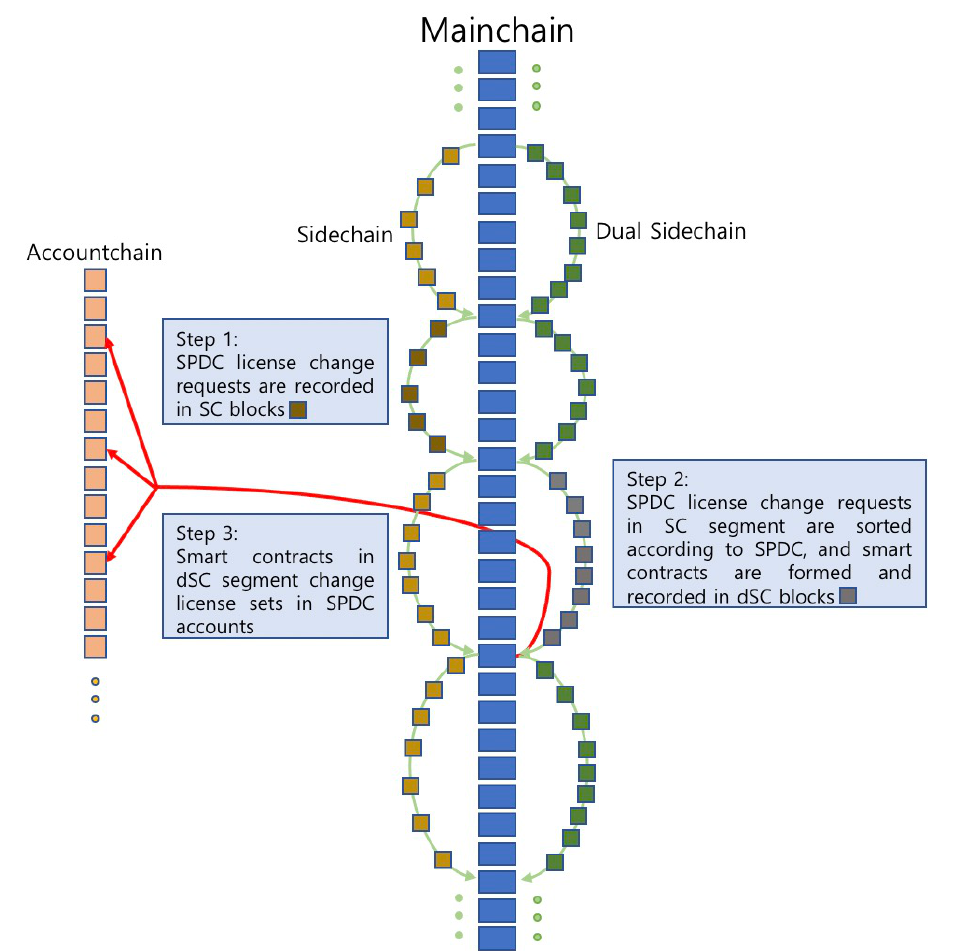
Figure 3. The process of changing an SPDC license in the